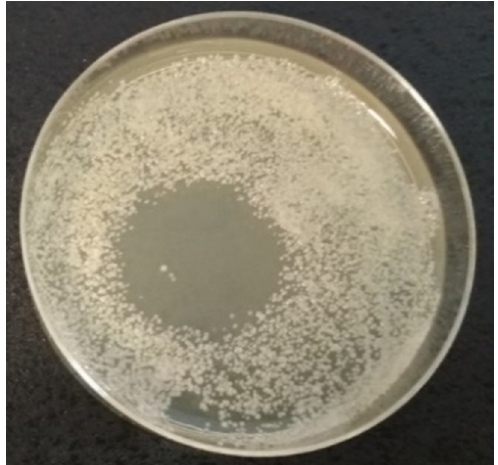
Figure 9. Picture of the largest zone created in the experiment using 12 W power for 5 min in the case of the 10-fold dilution.